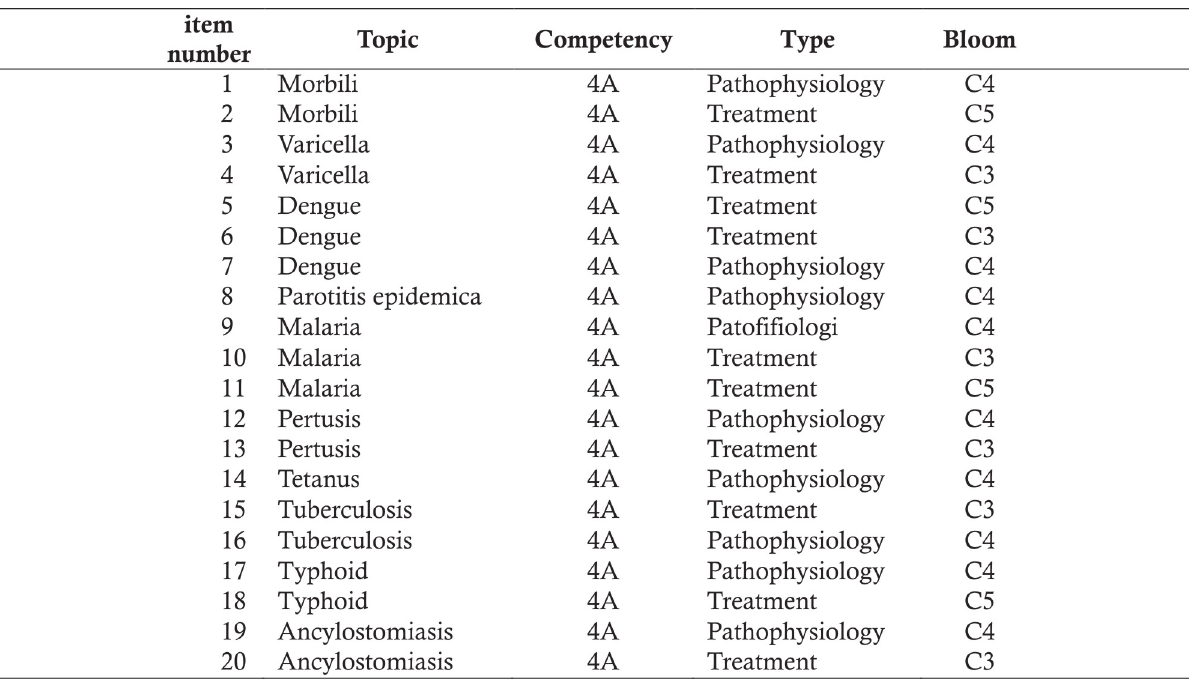
clinical reasoning competency for different levels of medical students such as pre clinical level and Table . Blue print assessment SCT items on pediatric tropical diseases cases